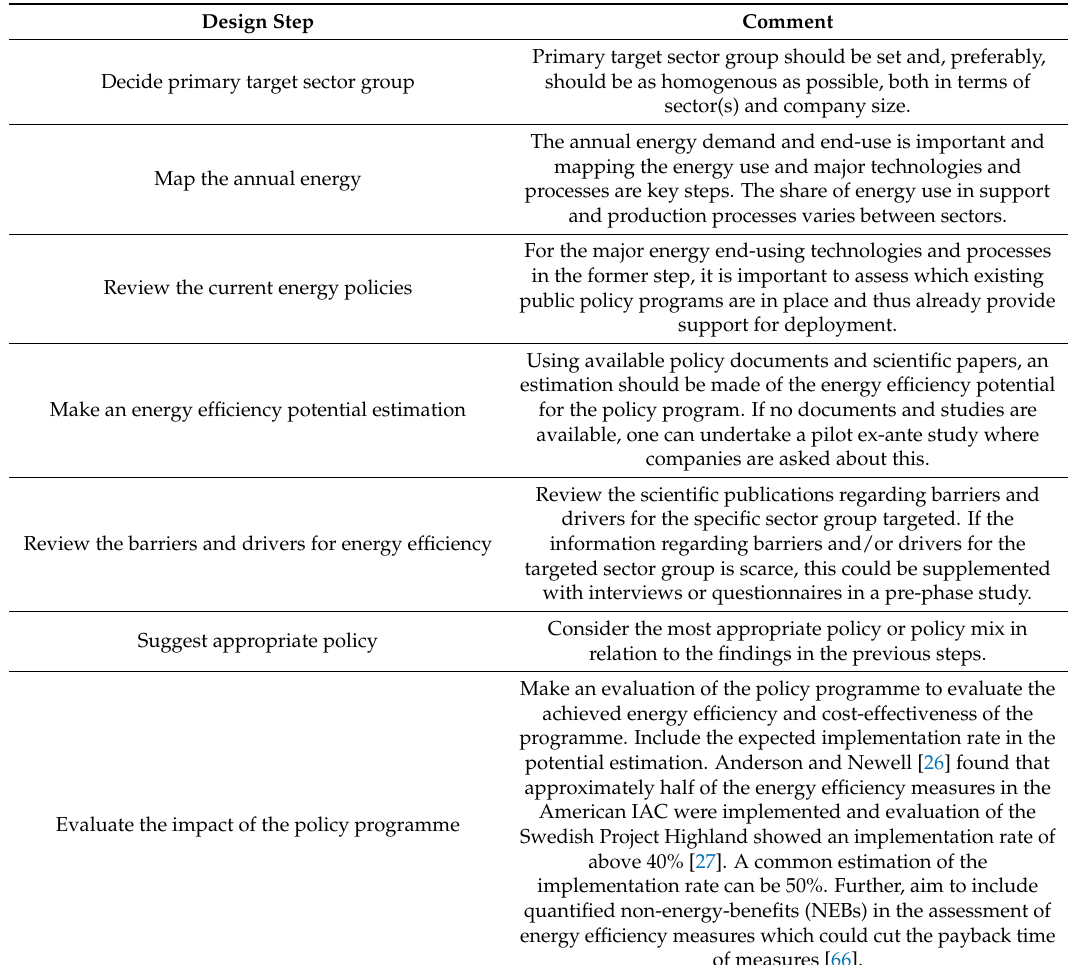
Table 1. Major steps when designing policies for small and medium-sized